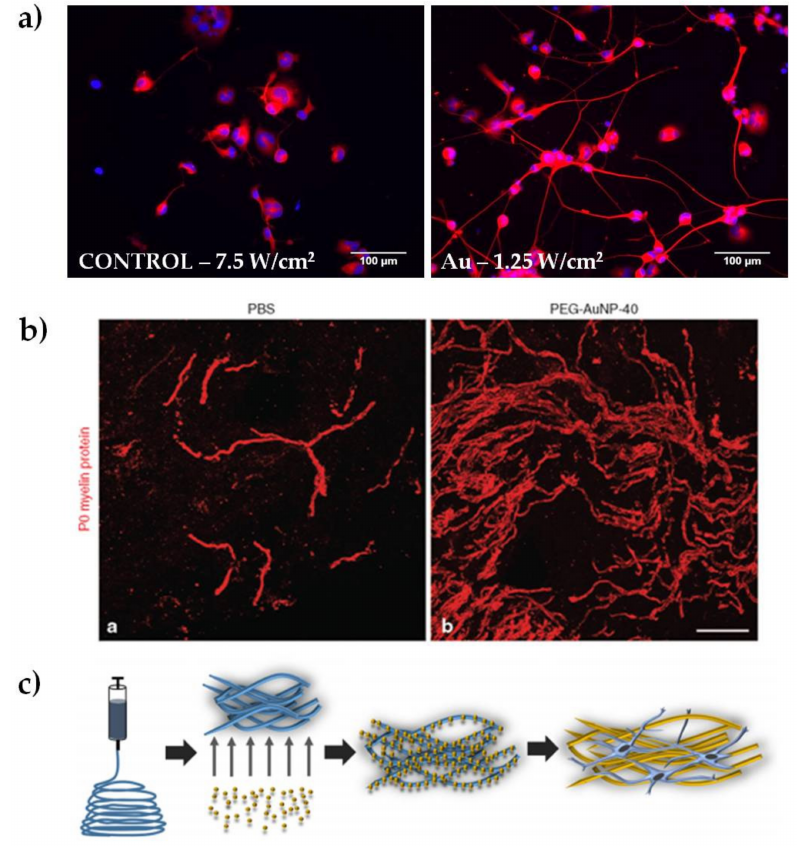
Figure 2. Representative results of Au NPs for peripheral nerve regeneration. ( a ) Examples of epifluorescence images of NG108-15 neuronal cells cultured alone or with Au NRs and exposed to different laser irradiances, as indicated in each panel. Cells were marked for β -III tubulin (in red) and DAPI (in blue, reproduced with permission from [49]); ( b ) Spontaneous remyelination by Schwann cells (myelin marker P0, in red) was enhanced in mice treated with polyethylene glycol-coated Au NPs (reproduced with permission from [7]); ( c ) schematic representation of electrospun nanofibers doped with 10 nm Au NPs (reproduced with permission from